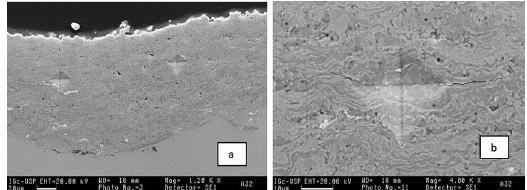
Figure 2. Secondary electron micrographs of HVOF sprayed nanostructured Cr C -25(Ni20Cr) coating: (a) shows uniform 3 2 structure, good bonding to substrate, smooth surface and two hardness measurement indents; (b) detail of (a) showing cracks emanating from the indent formed with a higher load.